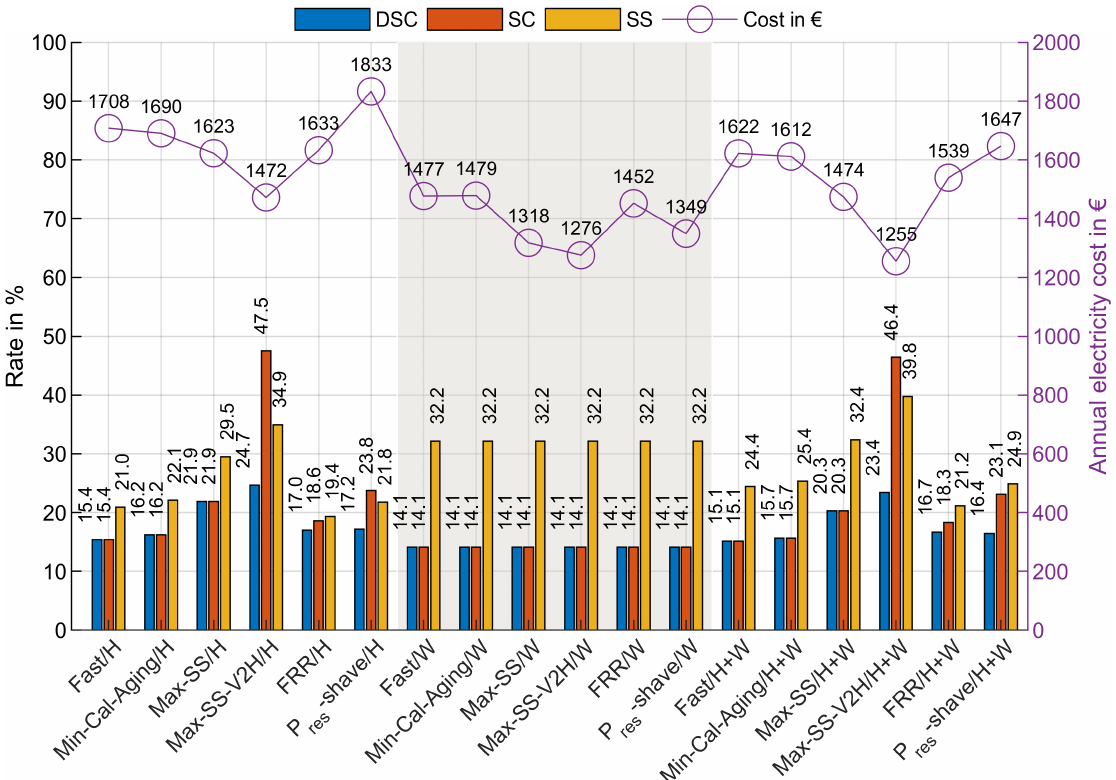
Figure 8. DSC, SC, and SS rates, and electricity cost for mobility profile Worker without SoC V 2 XLimit .